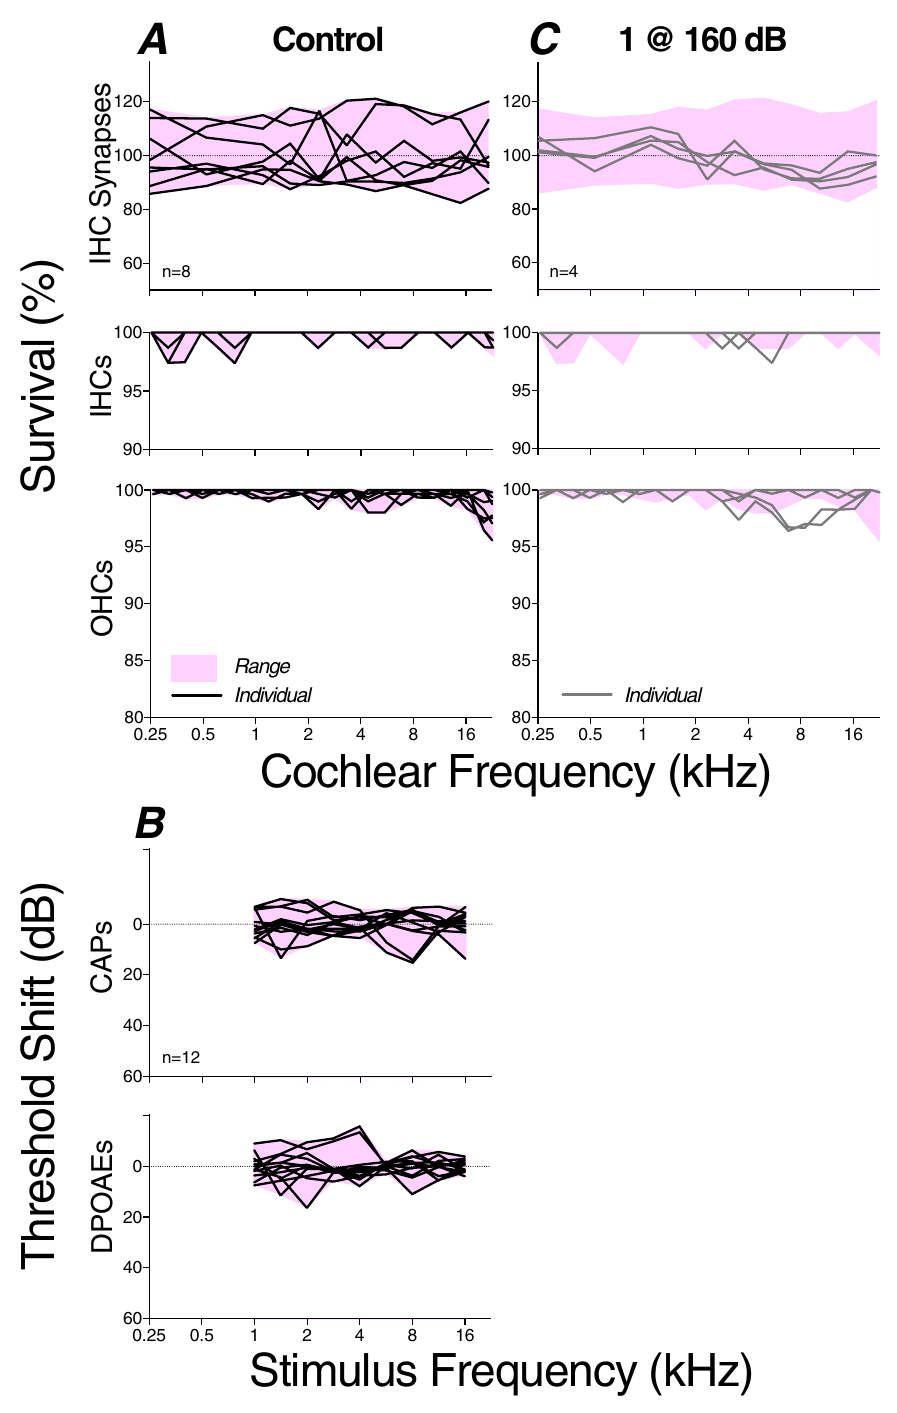
Figure 4. Summary histopathology ( A , C ) and physiology ( B ) from control ears (n = 8) and cases exposed to a single blast at the lowest SPL (n = 4; 160 dB peak). Data were obtained 1 wk post exposure. Each line in each panel is from a different case. Each IHC synapse value is derived from counts in two adjacent z-stacks, divided by the number of IHCs (including fractional values) in the same stacks. Each hair cell count is derived as shown in Fig. 3. Physiological measures were not obtained from this exposed group, thus there is no Panel D. All data are normalized to control